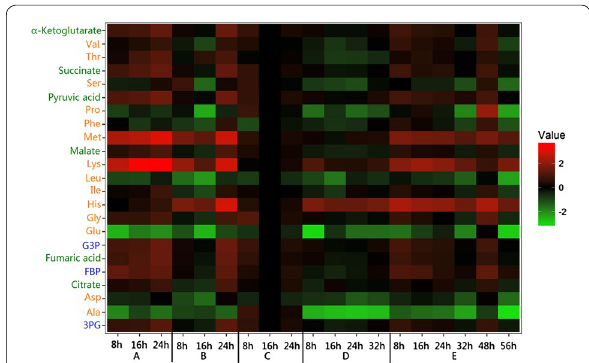
Fig. 6 Heat map of intracellular metabolites during seed culture process with different initial glucose